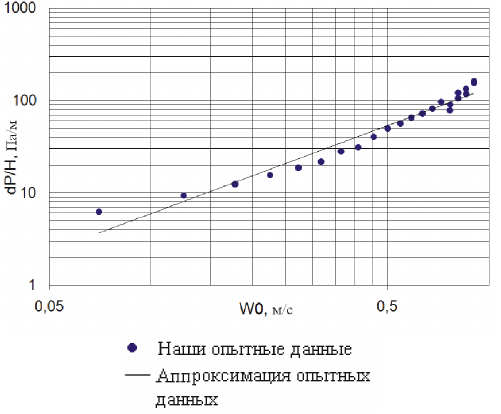
Рис. 7. График зависимости гидравлического сопро- тивления слоя насадки из N3C dP / H от скорости воз- духа W 0 , м/с